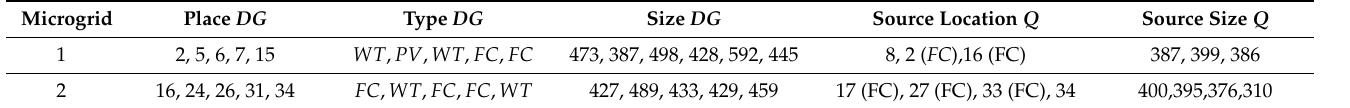
Figure 10. Network zoning into 2 microgrids in the third scenario. Which each zone in separated with different colors. Table 7. Specifications of resources installed in the network by kVAr and kW.